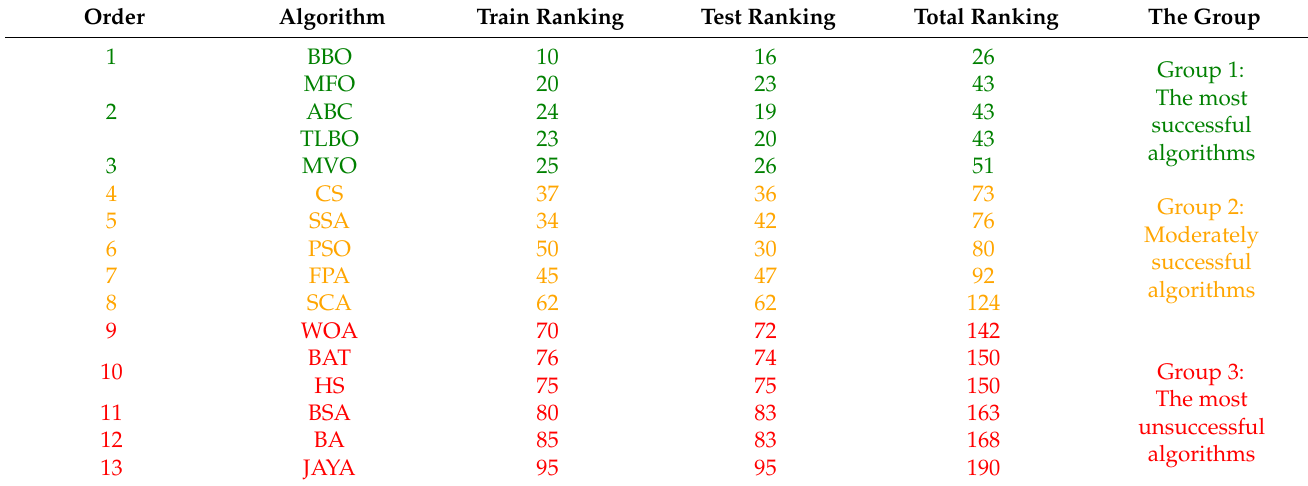
Table 14. General success scores according to the best results of the metaheuristic